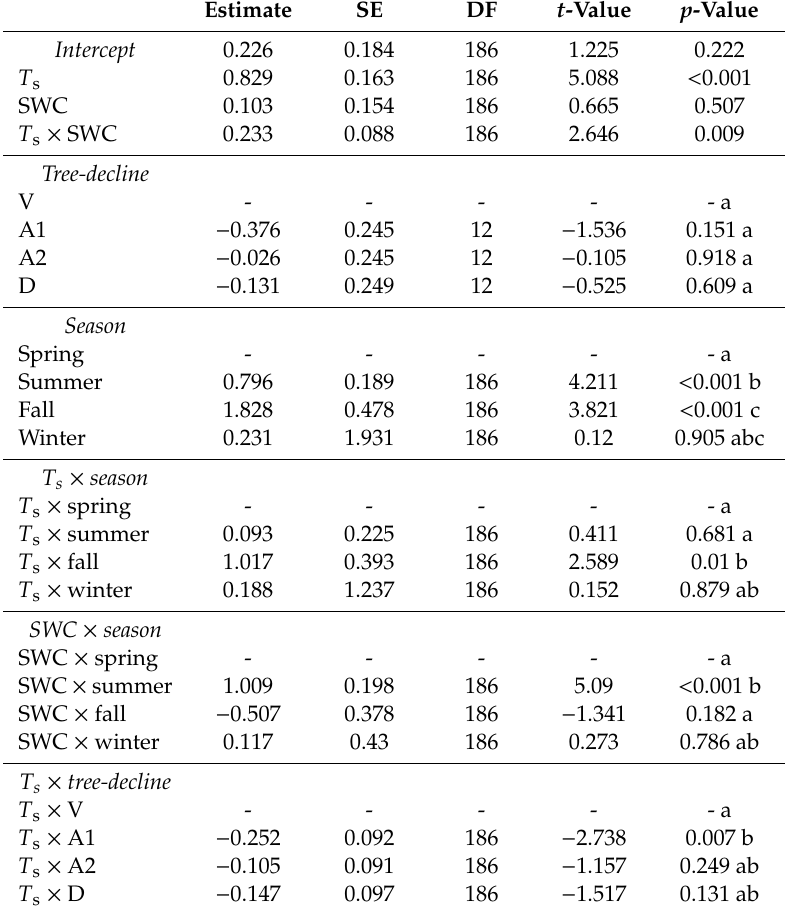
Table 2. Mixed e ff ects model of temporal variations in soil respiration as a function of soil temperature ( T s ), soil water content (SWC), tree-decline class (vigorous [V], a ff ected [A1], severely a ff ected [A2] and dead [D]) and season. The model explained 83% of the variation in R s and was significant at p < 0.001. Estimate SE